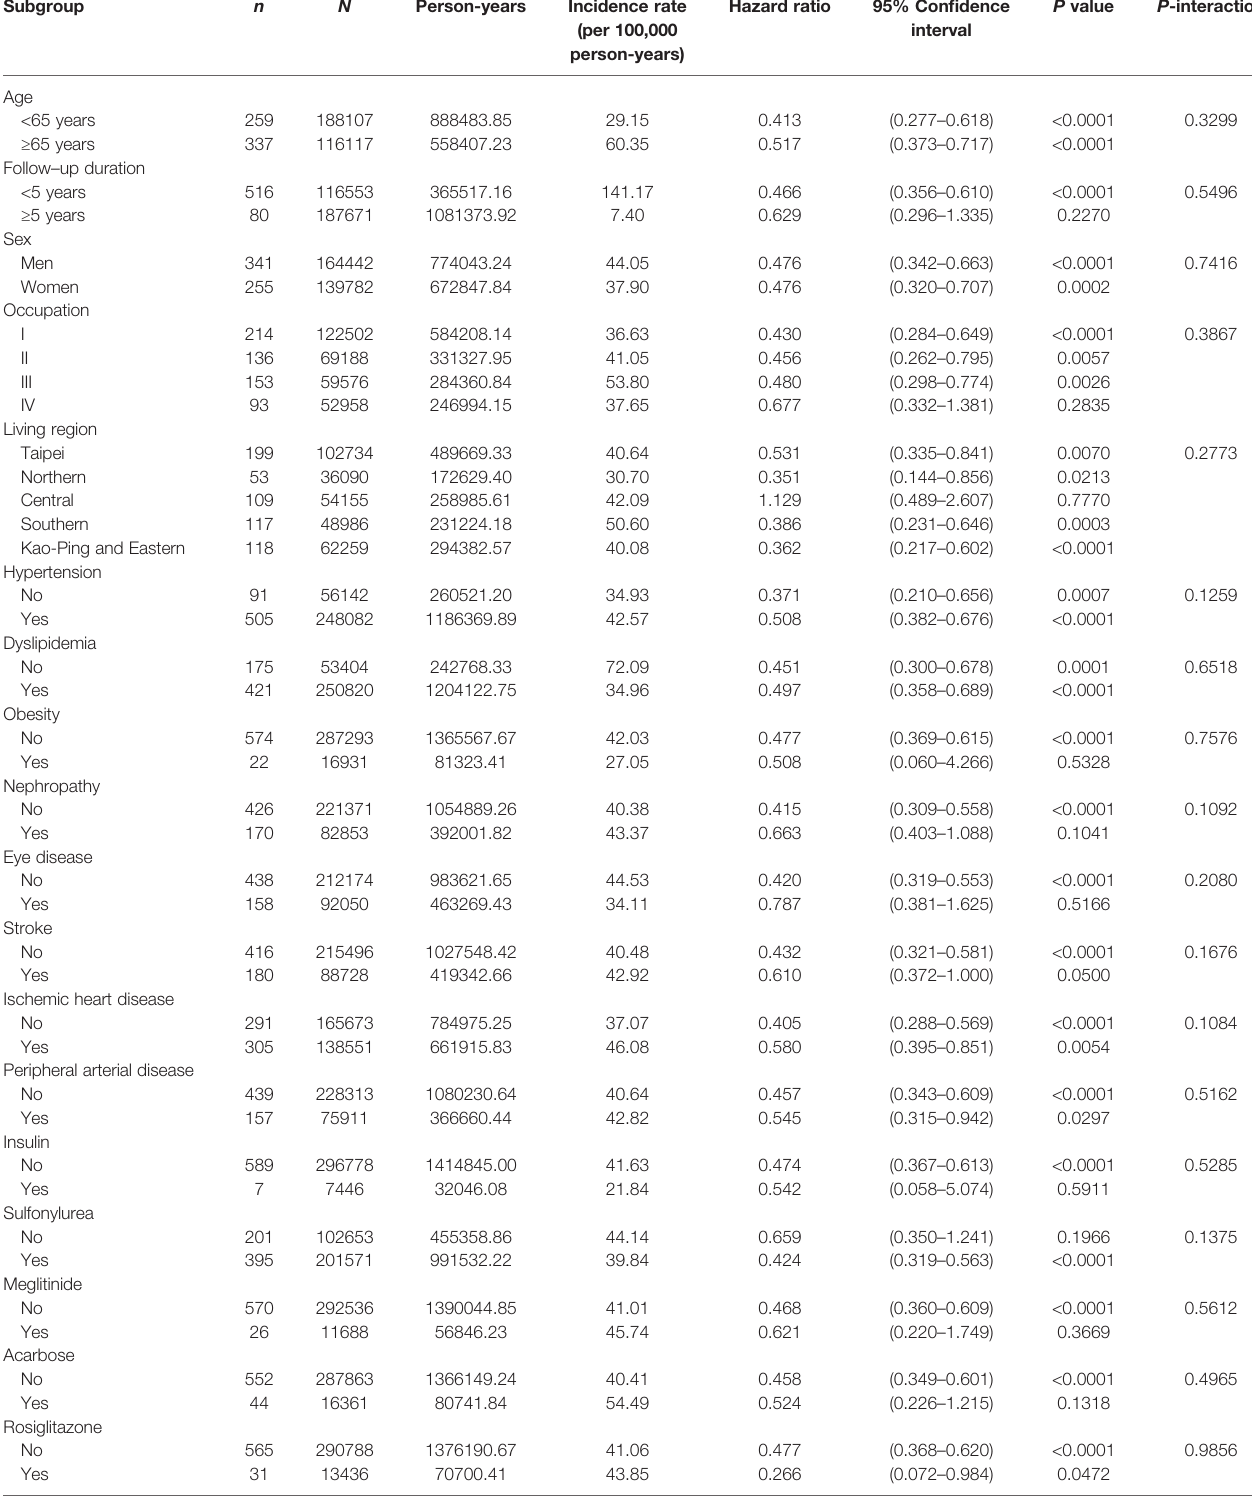
TABLE 4 | Subgroup analyses and P -values for the interactions between metformin and each of the variables.